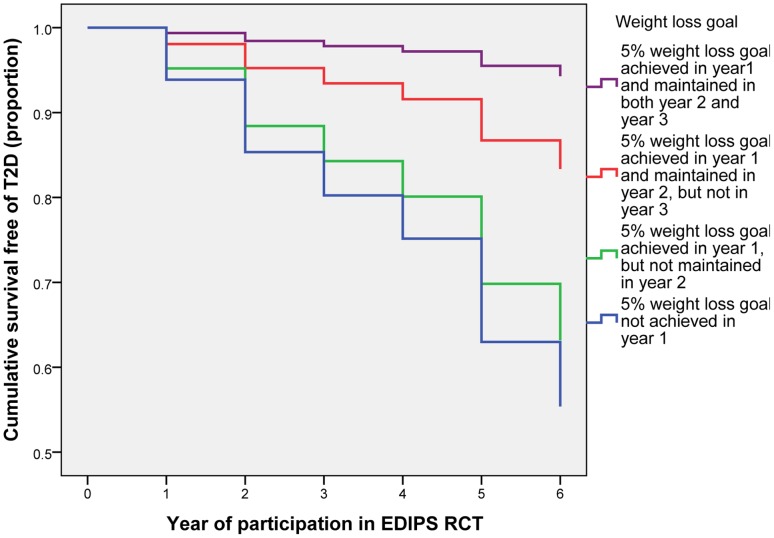
Progression to type 2 diabetes by weight loss achieved and maintained.